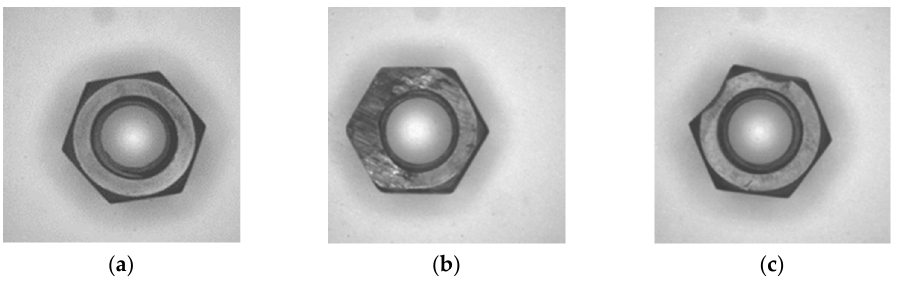
Figure 14. Abnormal nut after tapping: ( a ) circle anomaly; ( b ) plane anomaly; ( c ). line anomaly.